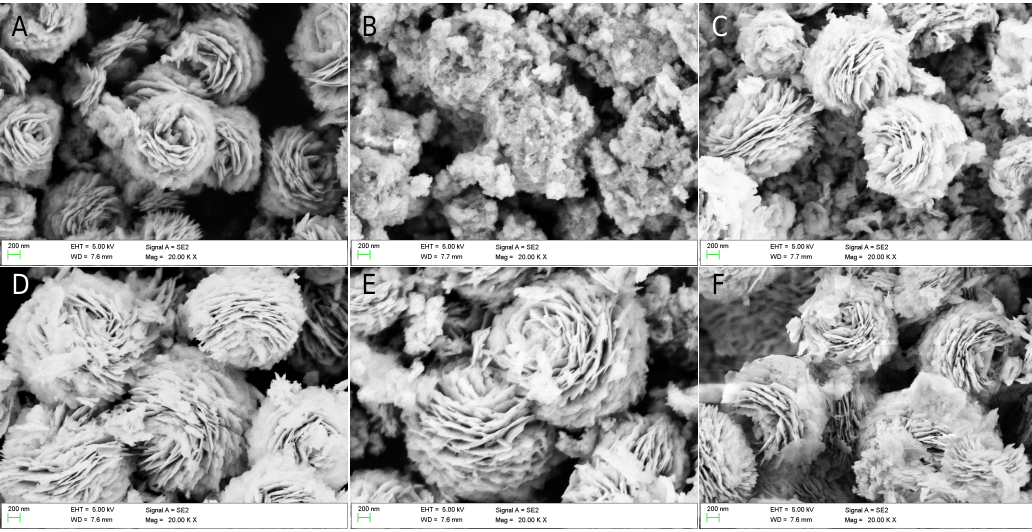
Figure 1. SEM images of the prepared photocatalysts: Bi 2 O 2 CO 3 ( A ), CdS QDs ( B ), Bi 2 O 2 CO 3 /CdS QDs-5 ( C ) Bi 2 O 2 CO 3 /CdS QDs-10 ( D ), Bi 2 O 2 CO 3 /CdS QDs-15 ( E ) and Bi 2 O 2 CO 3 /CdS QDs-20 ( F ).